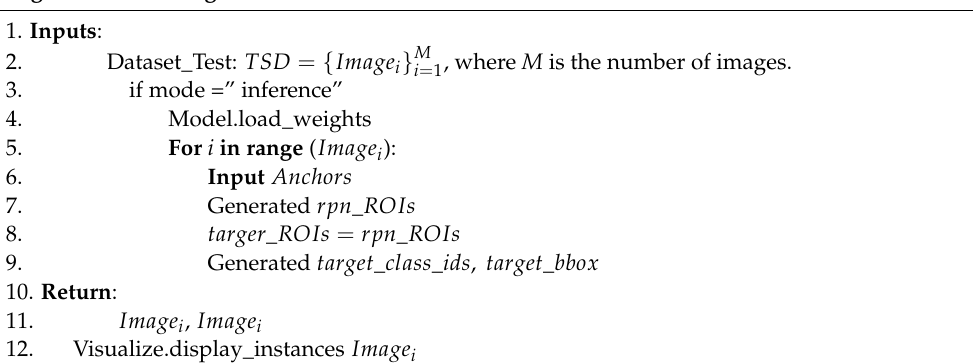
Algorithm 4. Testing Phase in Faster R-CNN